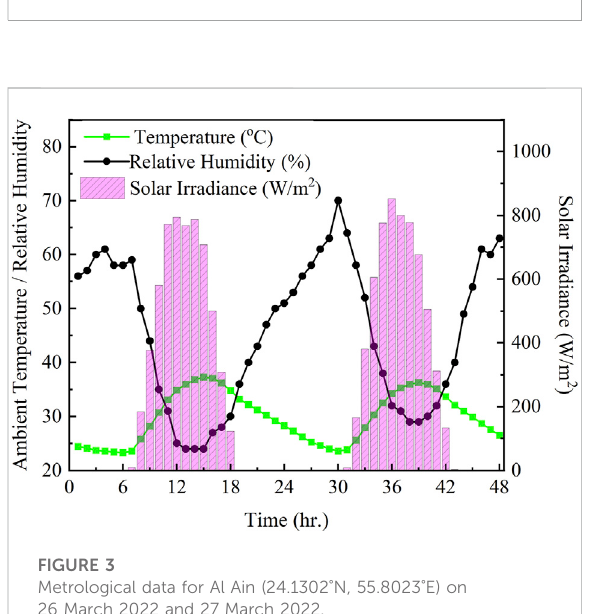
FIGURE 2 Camera calibration Work fl ow.